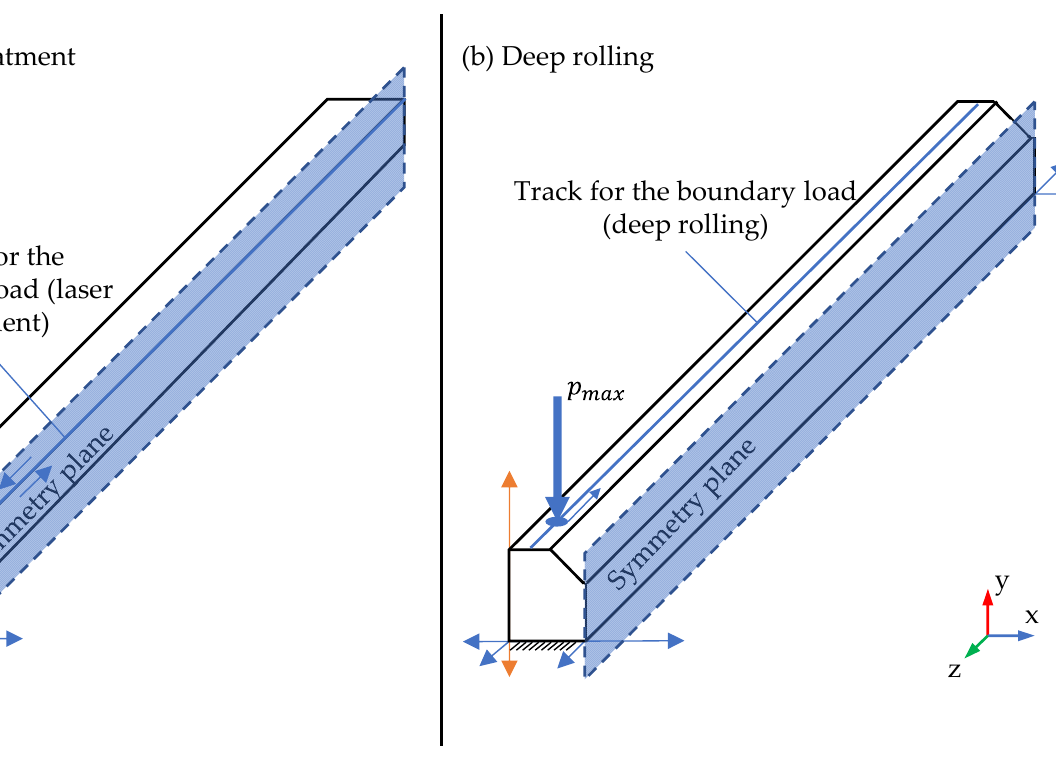
Figure 3. The applied boundary conditions for the two compensation processes: ( a ) laser treatment and ( b ) deep rolling for the simulation of the symmetric workpiece model .